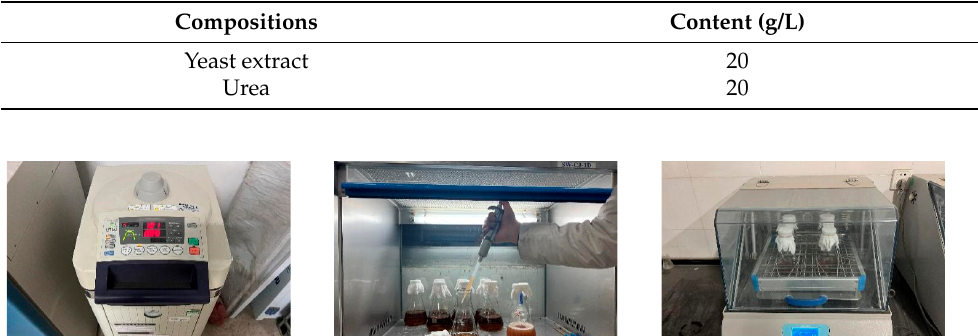
Table 1. The compositions of culture medium.